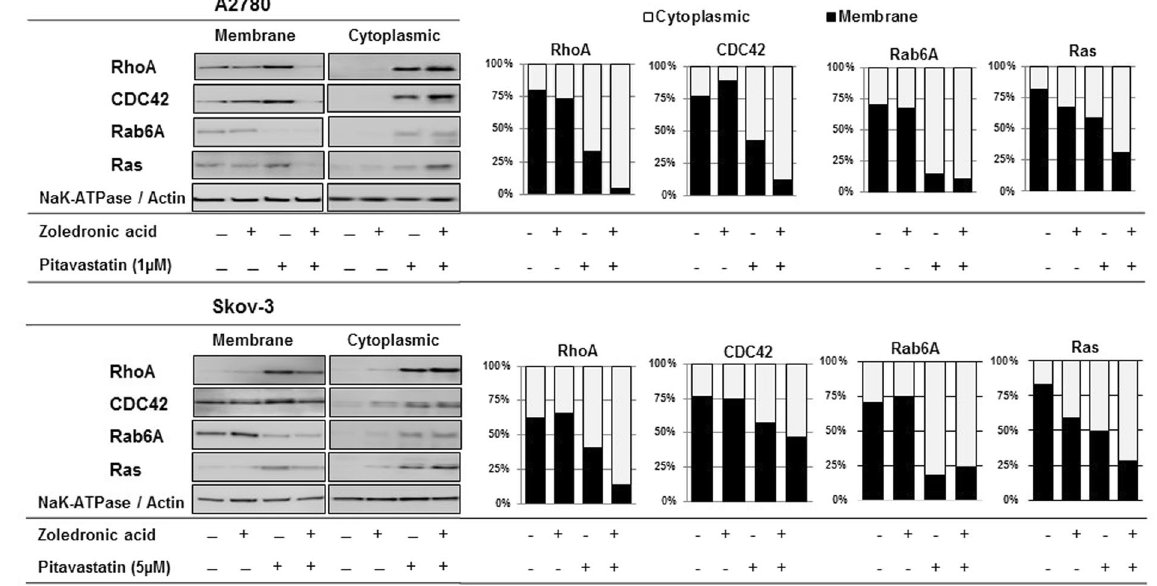
Figure 8. The effect of pitavastatin and pitavastatin-zoledronic acid on the subcellular localization of small GTPases. Lysates of A2780 and Skov-3 cells that had been treated with indicated drugs for 48 hr were fractionated into cytoplasm and membrane and analyzed by immunoblotting. The graphs show the mean fraction recovered in the cytosolic or membrane fractions (n =